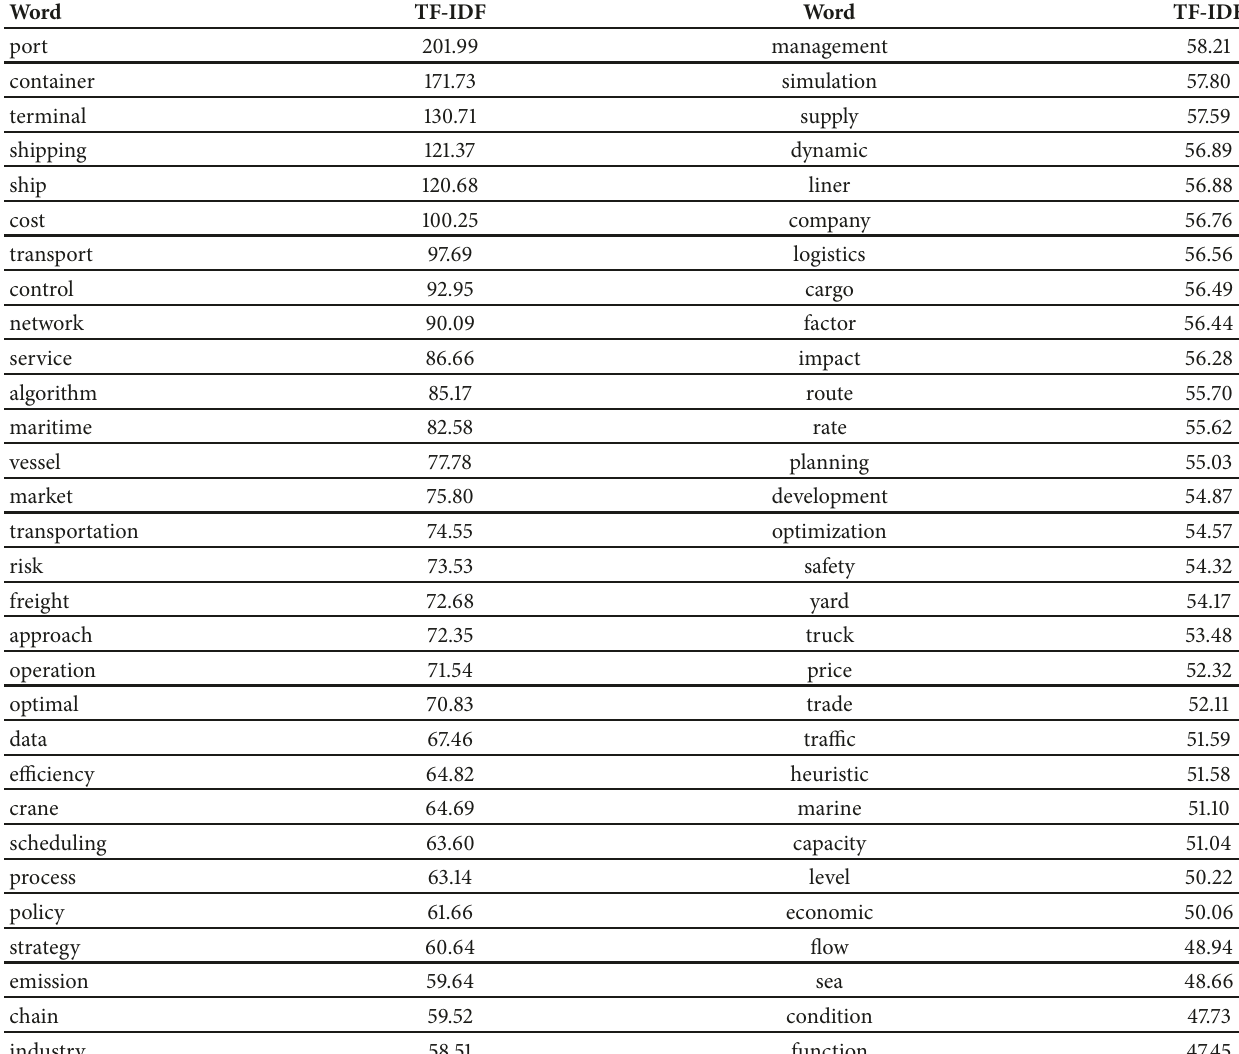
Table 10: The top 60 research terms.